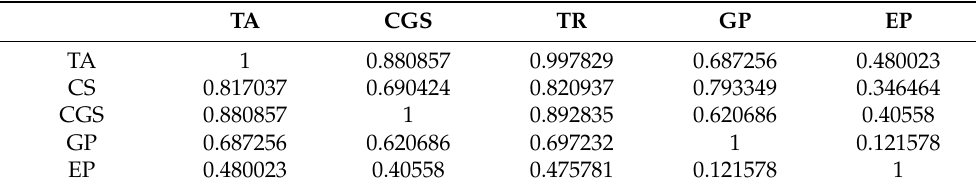
Table 17. The results of correlation